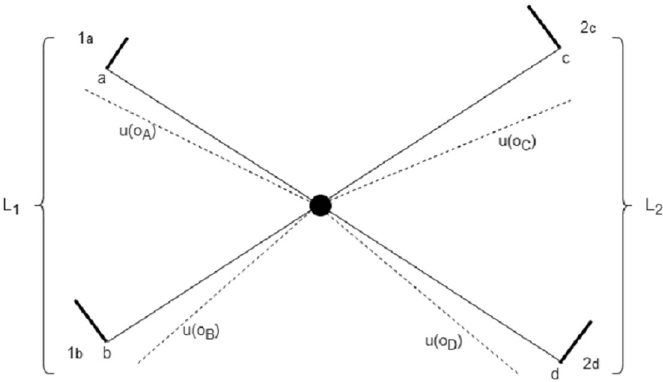
, p ; o , 1 − p } and L 2 = { o , q ; o , A B C D , 1 , 2 , 2 } respectively. The thick bars at a b c d